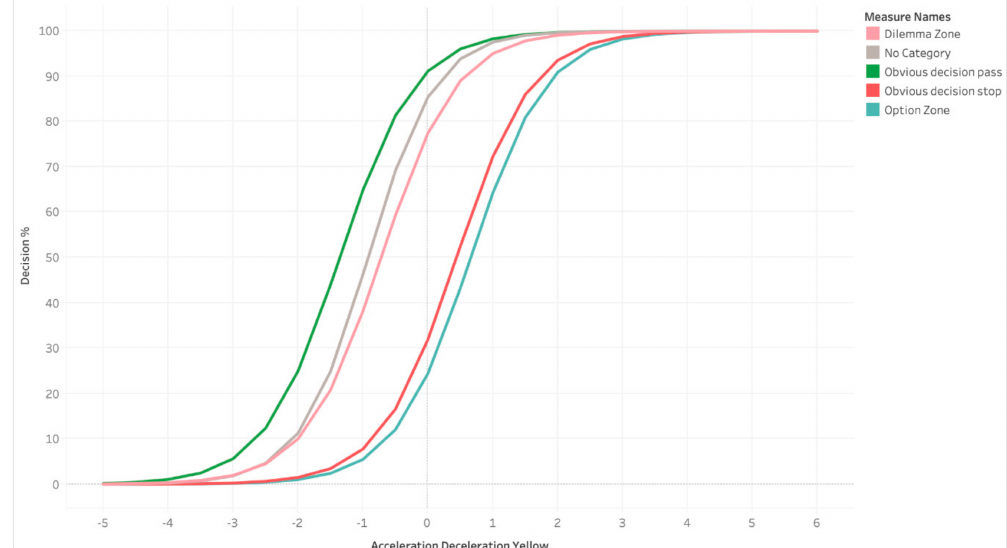
Figure 8. Distribution of decision probability depending on changes in acceleration and the relative position of vehicles (aggressive drivers).